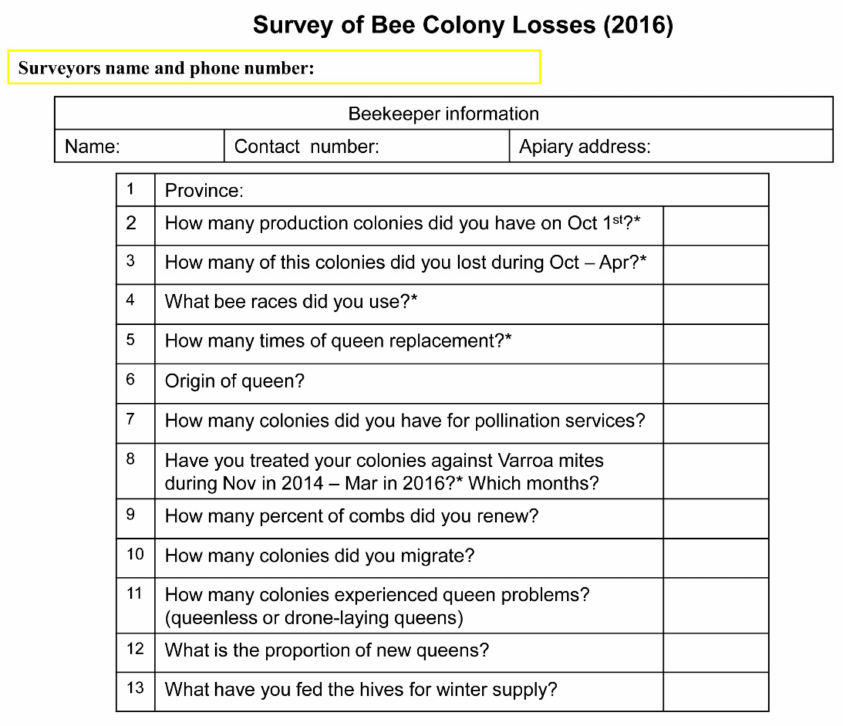
Figure 1. An example of a modified questionnaire based on the standardized questionnaire from COLOSS monitoring working group combined with beekeeping situations in China. The asterisk indicates required questions that would not allow a blank response on the